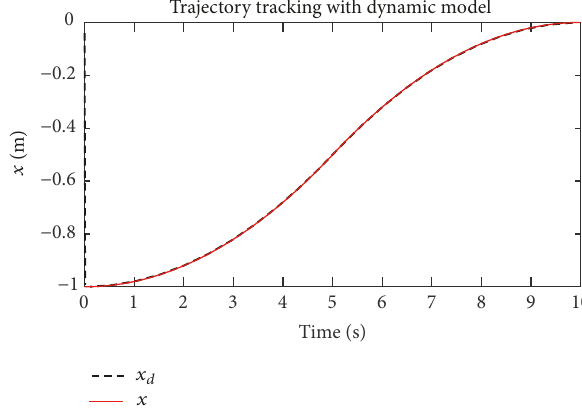
Figure 12: The 𝑥 trajectory tracking using the predictive control joined with the dynamic model.